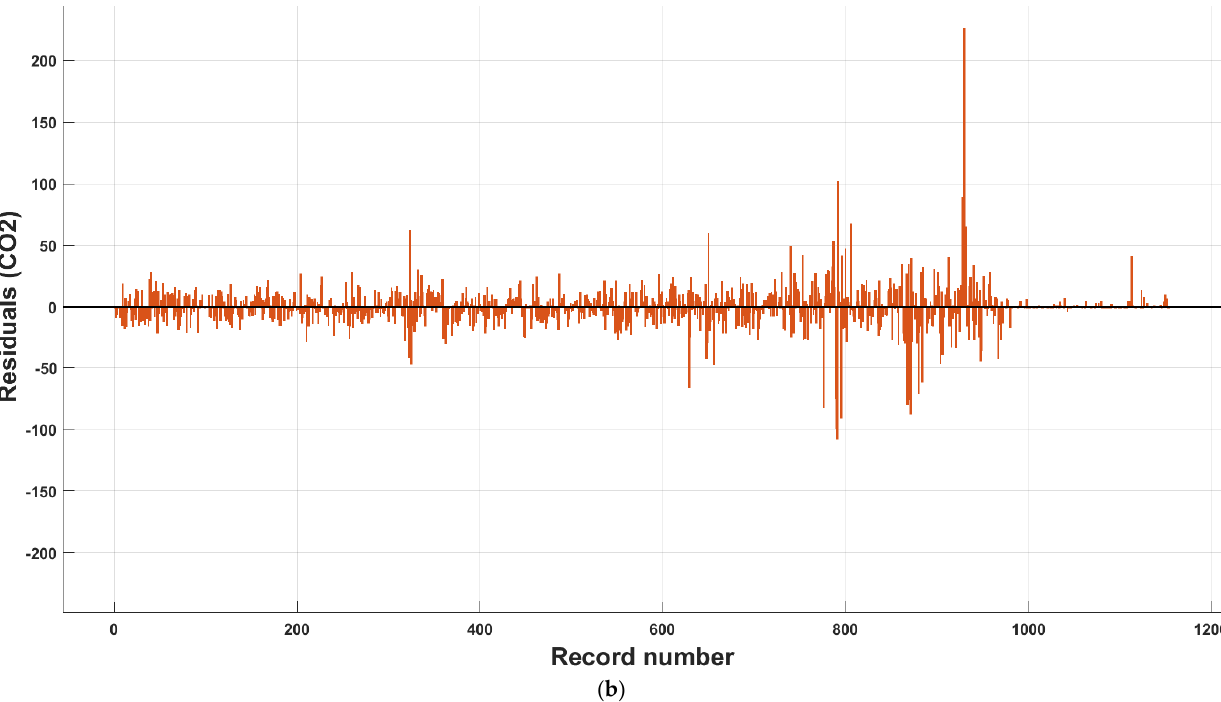
Figure 11. The Bi-cluster formation from QU-H10 and QU-C05 data-captured during 8 h from CO2 and Temperature Variables: ( a ) The OBRM1 Response for Temperature (°C) and ( b ) The OBRM2 Response for CO2 (ppm).